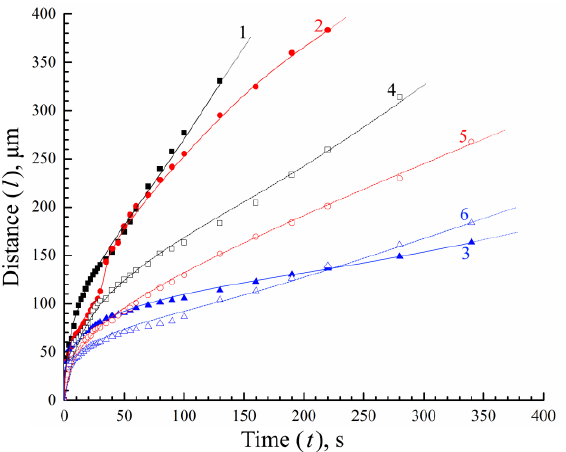
Figure 7. Time dependence of the depth of the structure formation front (solid dots: nonsolvent–pure water; hollow dots: nonsolvent–TG mixed with water in the 1:1 ratio). Black dots refer to the parent mixture containing 10 wt.% PLGA; red dots — 20 wt.% PLGA; blue dots — 30 wt.% PLGA.